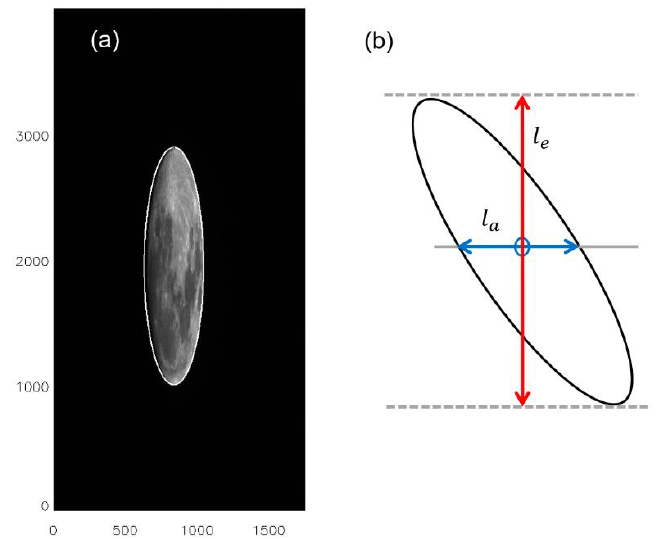
Figure A2. ( a ) An example of ellipse fitting for elongated lunar images (Band 1 for 2017). The standard deviation of residuals between the fitted ellipse and the locations of the extracted limb points in this example was 0.5 pixel whereas 𝑙 𝑎 and 𝑙 𝑒 as shown in ( b ) were 413 and 1893 pixels, respectively.